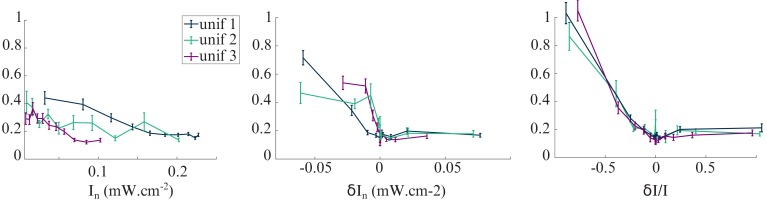
Variance of δ⁢θ as a function of three different illumination parameters.Testing klinotaxis with spatially uniform illumination (orientational profiles unif 1–3). Change in variance of δ⁢θ at bout n for two different parameters : absolute intensity In, absolute change in intensity δ⁢In=In-In-1 and relative change in intensity δ⁢I/I=2⁢In-In-1In+In-1.